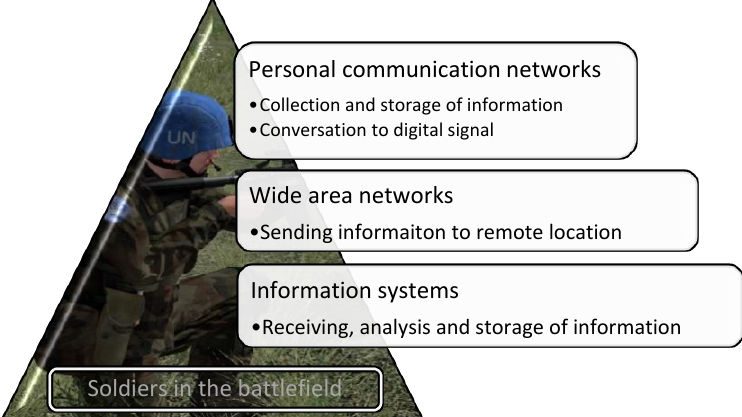
Figure 8. Three areas of communication devices for military applications.